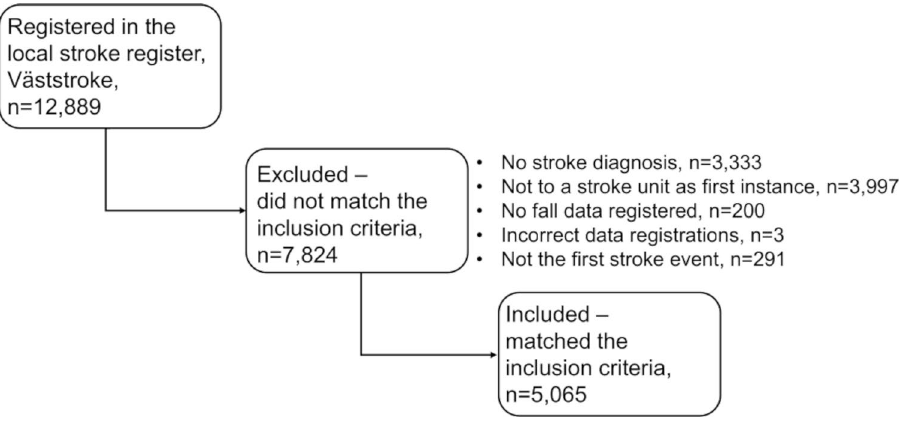
Figure 1. Flow chart for